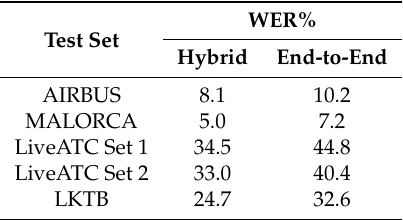
Table 2. Performance of our current speech-to-text systems for both the hybrid and end-to-end approach. Measured in Word Error Rate (WER).